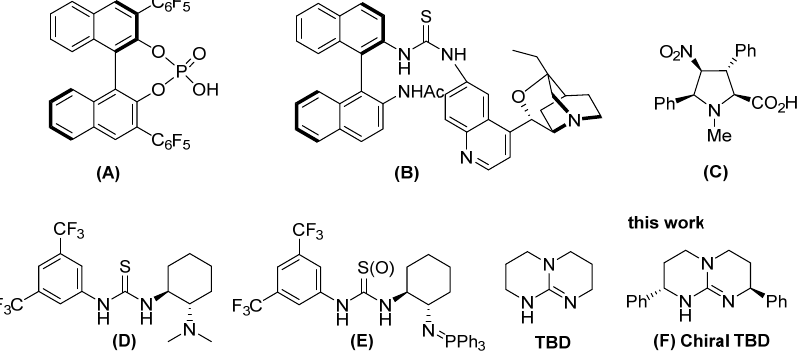
Figure 1. Chiral organocatalysts (A–F) used for the stereocontrolled ROP of rac ‐